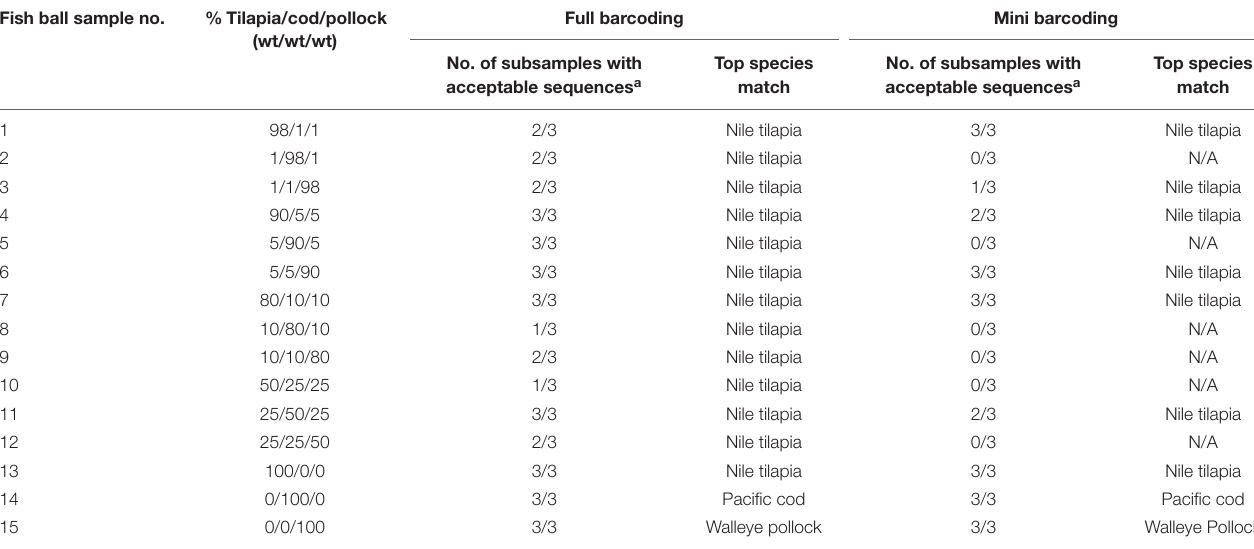
TABLE 1 | Sequencing results for fish ball subsamples tested with standard DNA barcoding techniques (no PCR cloning). Fish ball sample